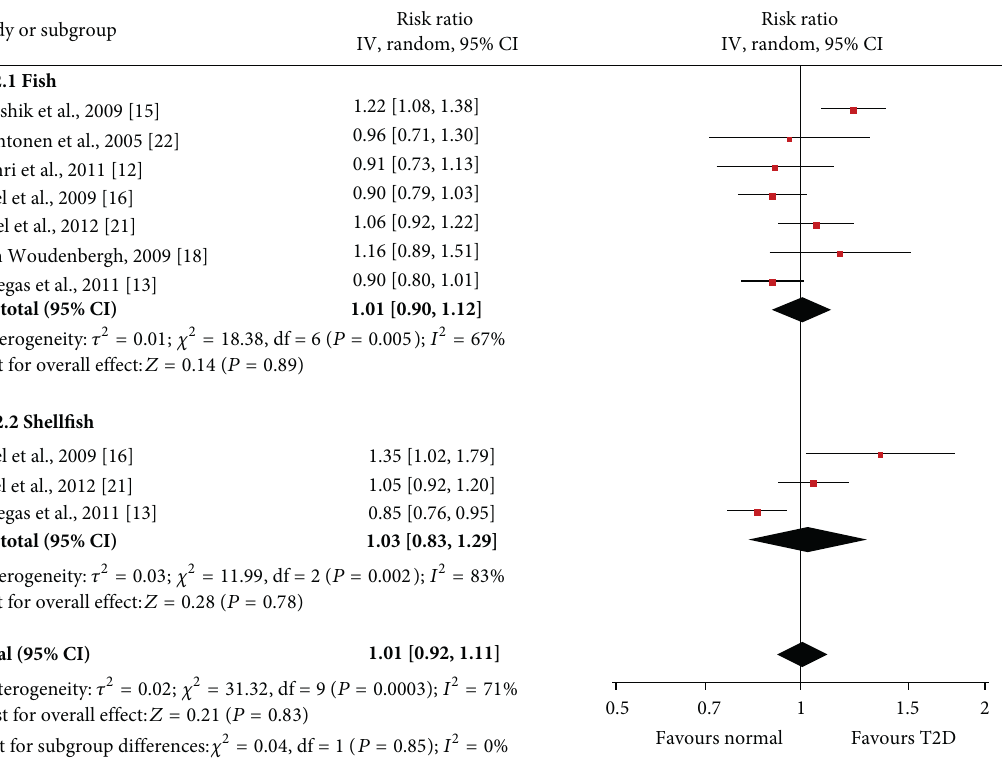
Figure 5: Forest plot of the meta-analysis for fish and shellfish intake and incidence of type 2 diabetes.